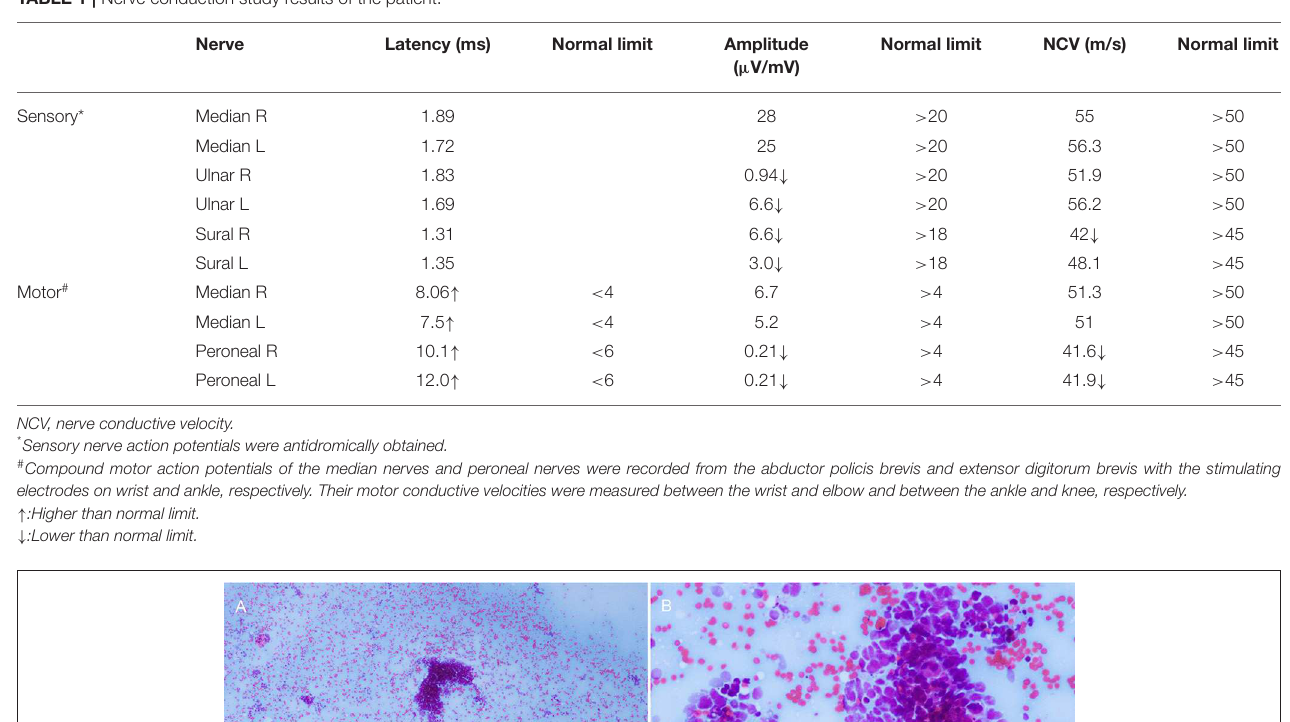
Normal limit NCV (m/s) Normal limit ( µ V/mV)